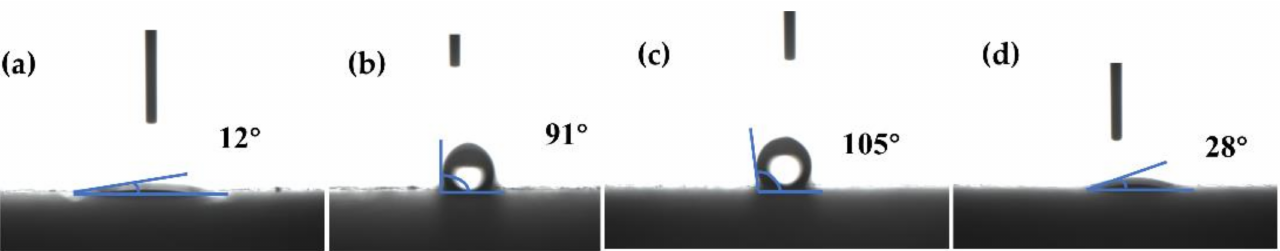
Figure 5. Contact angles of ( a ) sample SiON, ( b ) sample B72, ( c ) sample PDMS, and ( d ) sample